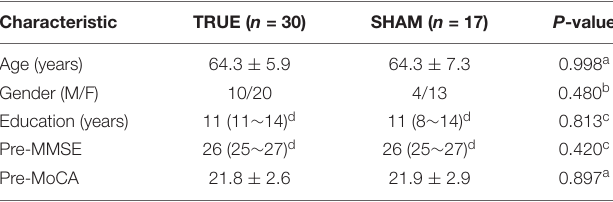
TABLE 2 | Demographic and clinical conditions of two mild cognitive impairment groups.